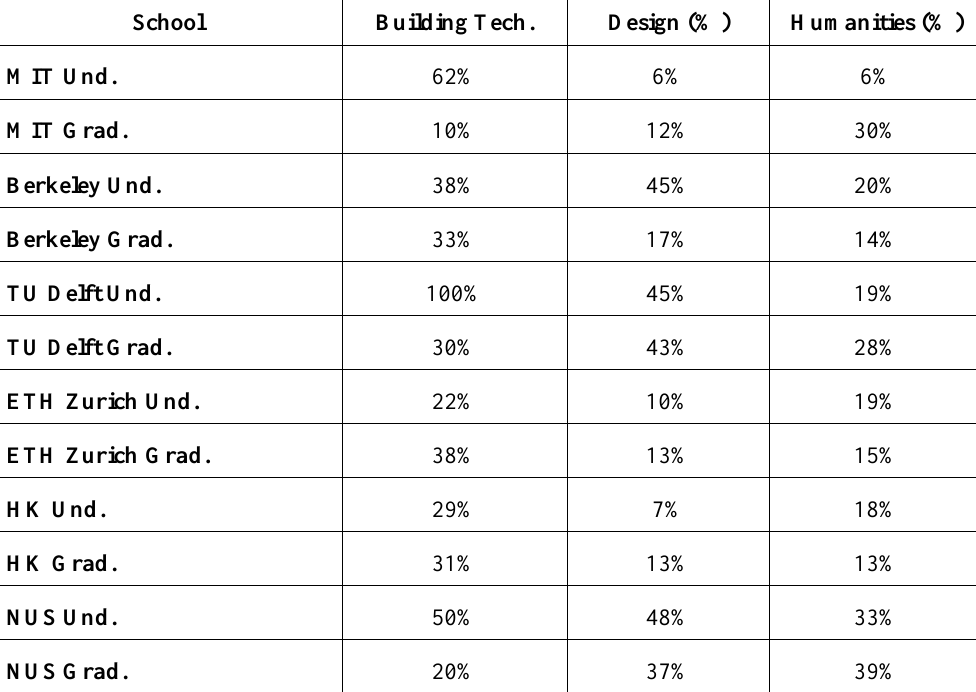
Table 2. Percentage of Environmentally Aware Lectures by Program and